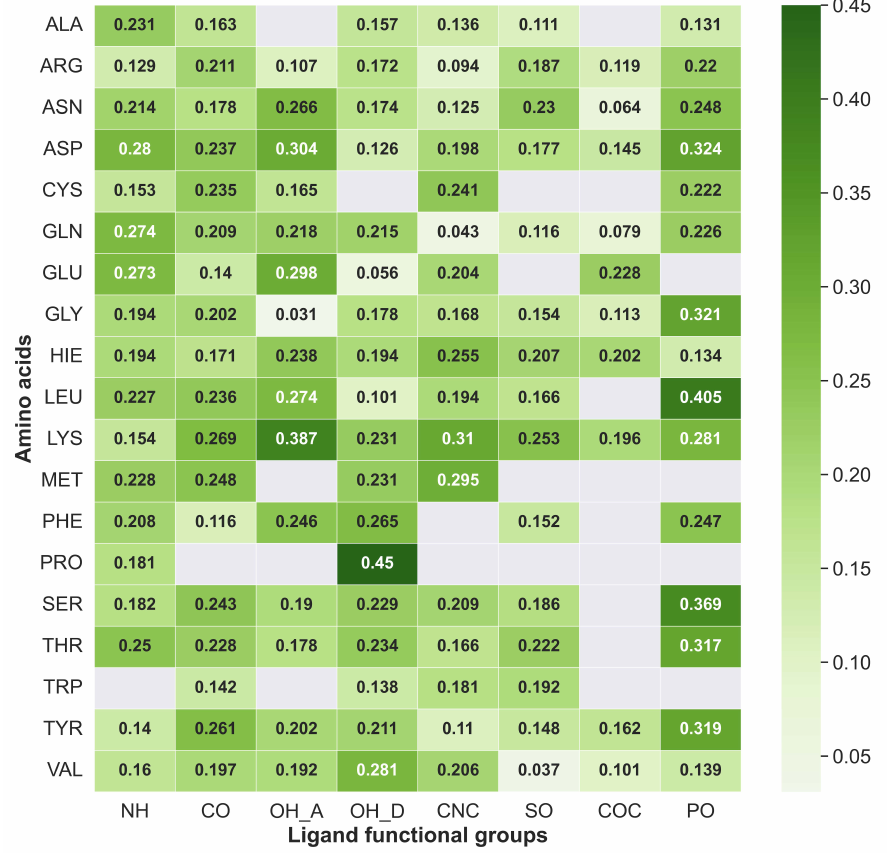
Figure 10. Average strength of the hydrogen bonds between each amino acid residue and 8 most common ligand functional groups (strength map). The white color squares mention a null value representing that these types of hydrogen bonds are not reported in this study. Ligand